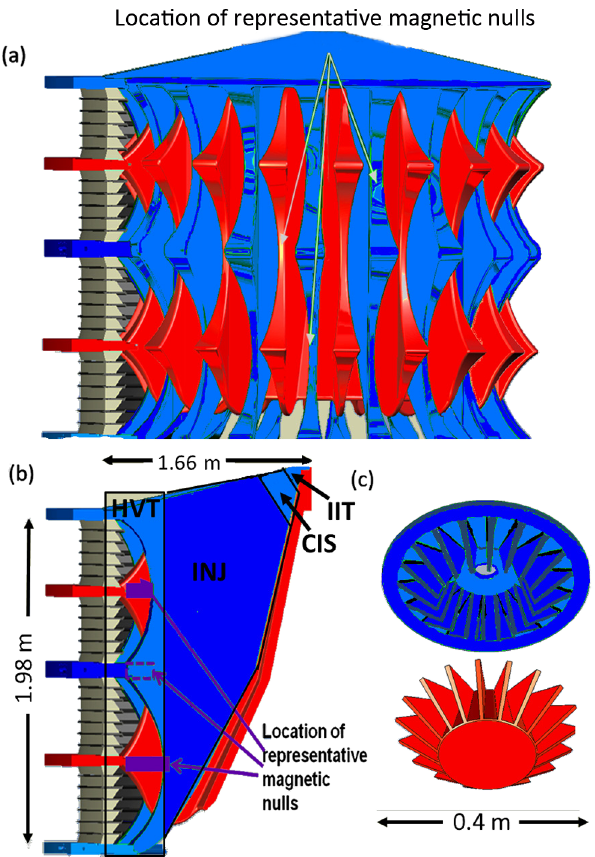
FIG. 2. (a) Side view of the CSMITL with the anode in blue and the cathode in red. A cutaway of the vacuum insulator stack shows how the CSMITL is connected to the high voltage cathodes and the grounded anodes. The locations of represen- tative magnetic nulls are shown by arrows. (b) A cutaway view of the CSMITL, showing the anode and cathode vanes. The location of the magnetic nulls from the anode vanes are noted; the corresponding magnetic nulls to the cathode vanes are opposite the center anode. The approximate positions of the horizontal-to- vertical transition (HVT), injector (INJ), constant impedance section (CIS), and increasing impedance transition (IIT), which includes the disk feed, are shown. (c) Detail of the expendable center electrodes, which are part of the IIT. The structure of the vanes and the transition to the disk feed are evident. The load would mate to the edge of the hole in anode (blue) and the top of the cathode (red), which is outside the field of